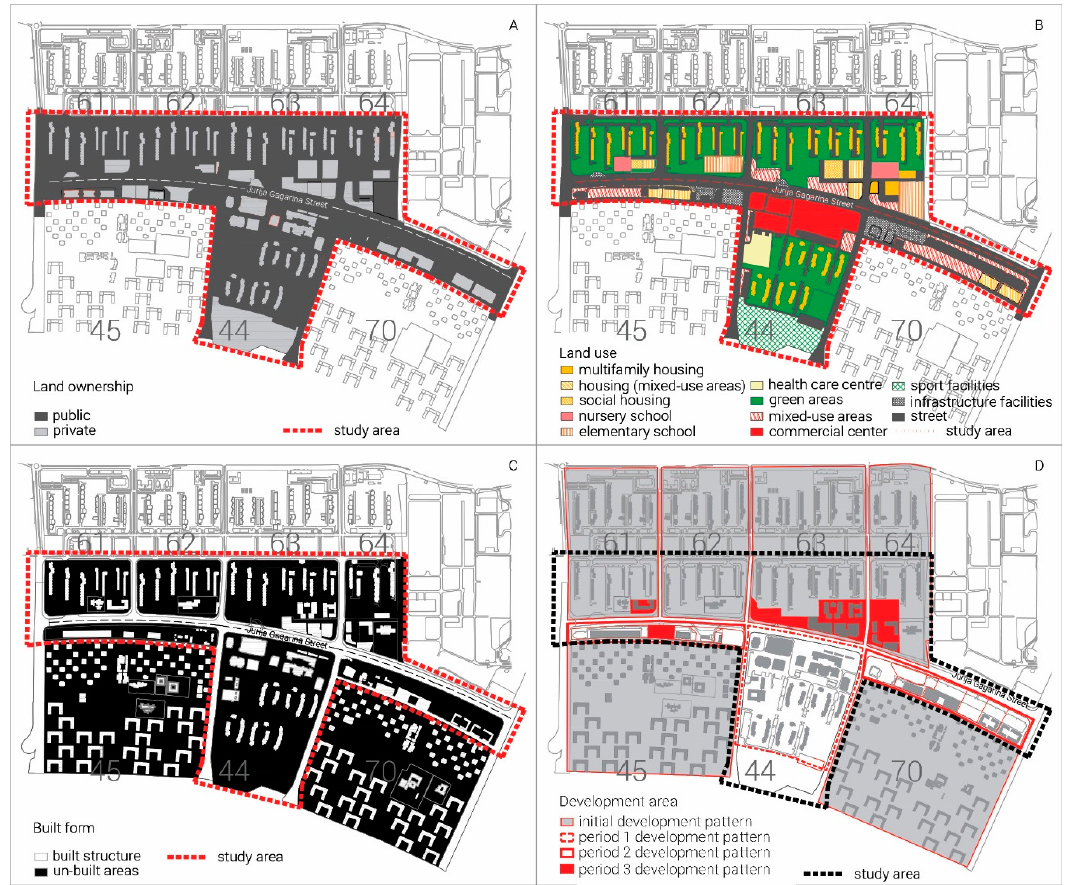
Figure 6. Morphogenesis of Jurija Gagarina Street, period 3: ( A ) Land ownership, ( B ) land-use, ( C ) built form, and ( D ) pattern of growth (source: authors).